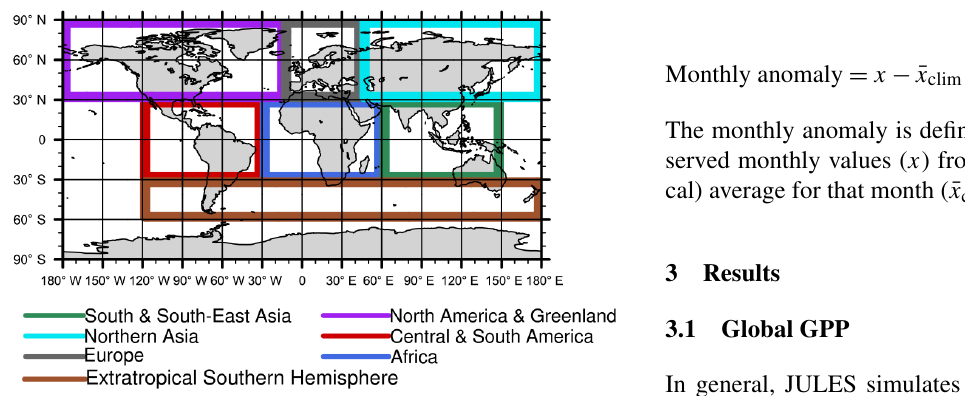
Figure 1. Map showing the regions specified in Table